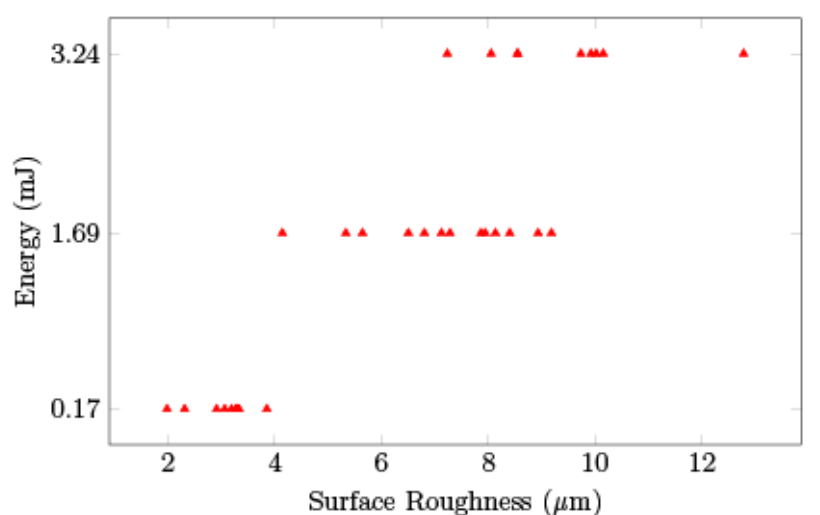
Figure 19. Comparison histogram of model characteristics for Ra.